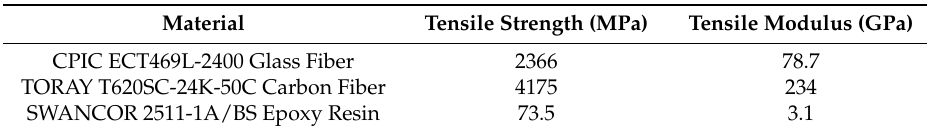
Table 1. Constituent materials and selected properties.